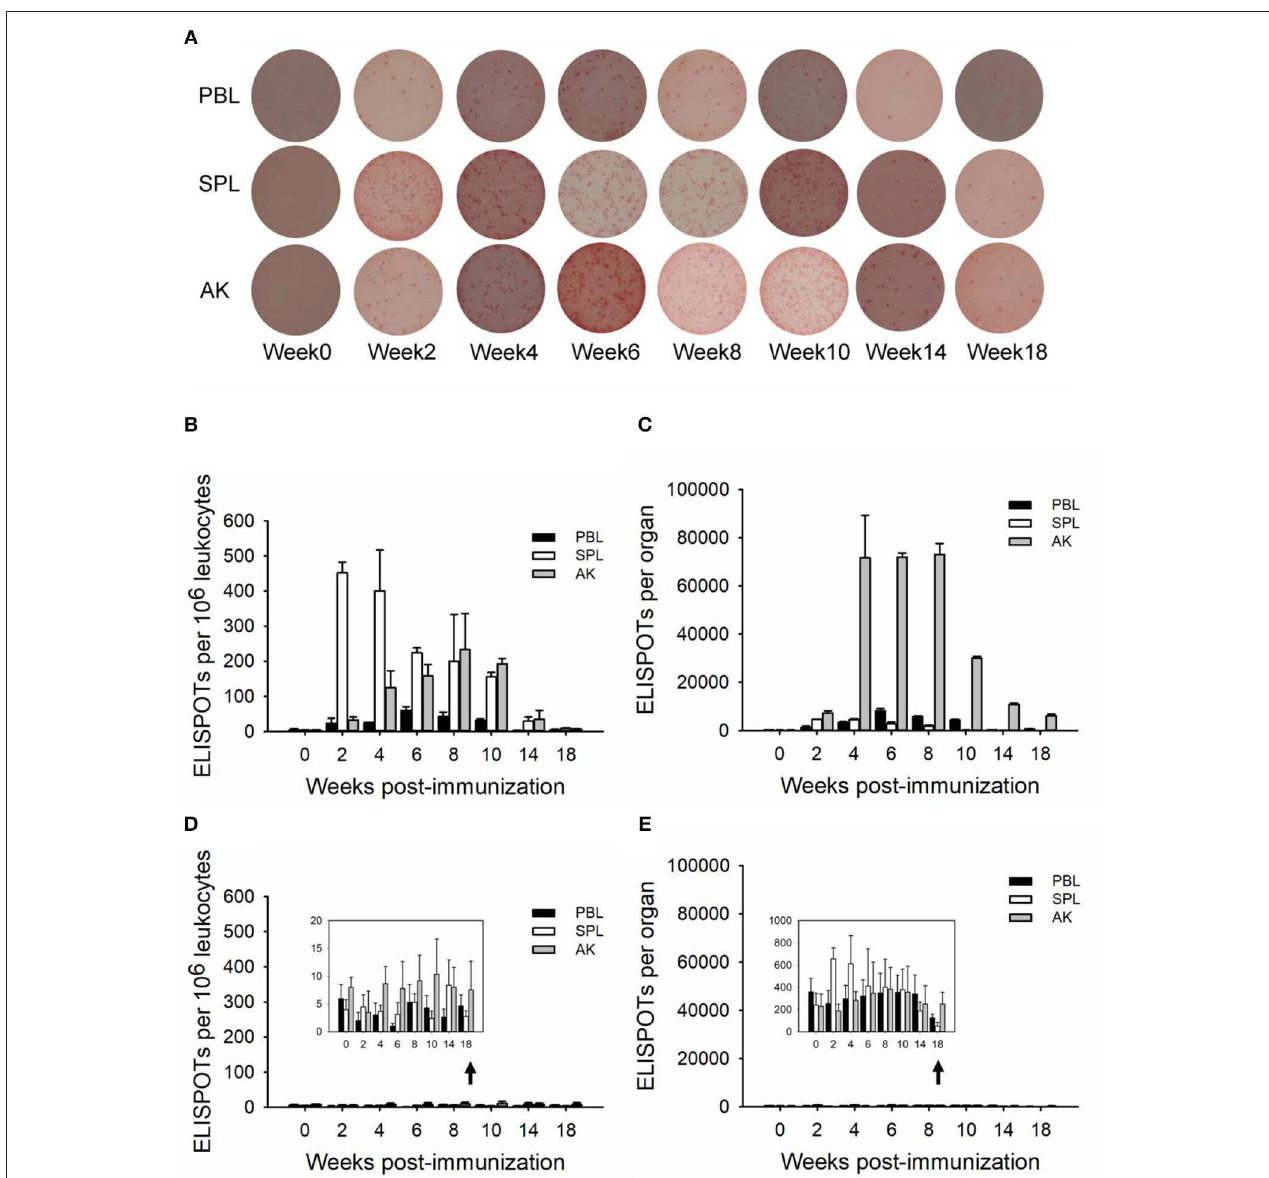
FIGURE 2 | ELISPOTs of anti-TNP-specific antibody-secreting cells (ASCs) ( in vivo ) in immune tissues. The ELISPOTs of the in vivo ASC response within peripheral blood (PBL), spleen (SPL), and anterior kidney (AK) were shown from an individual fish immunized with TNP-KLH by 1 × 10 6 leukocytes per well (A) . The average number of ASCs per 10 6 leukocytes (B,D) and the total number of ASCs in each tissue (C,E) were detected at weeks 0, 2, 4, 6, 8, 10, 14, and 18 post-immunization ( n = 5) with TNP-KLH (B,C) and PBS (D,E) . Data represent the mean ± SD of five individual fish at each time point and are representative of three independent